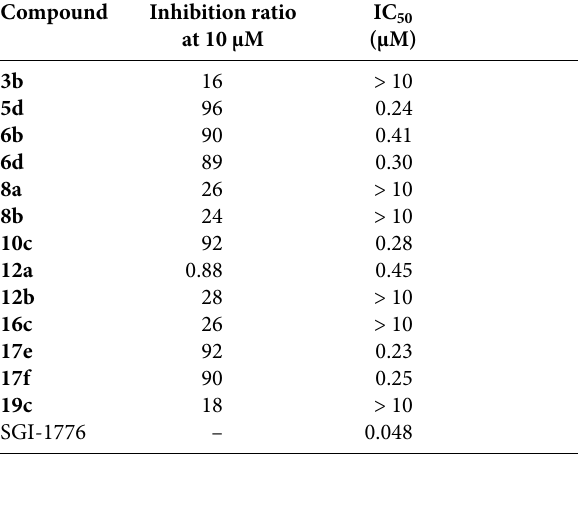
Table 3. The inhibitory activity of compounds 3b , 5d , 6b , 6d , 8a , 8b , 10c , 12a , 12b , 16c , 17e , 17f and 19c toward Pim-1 kinase.